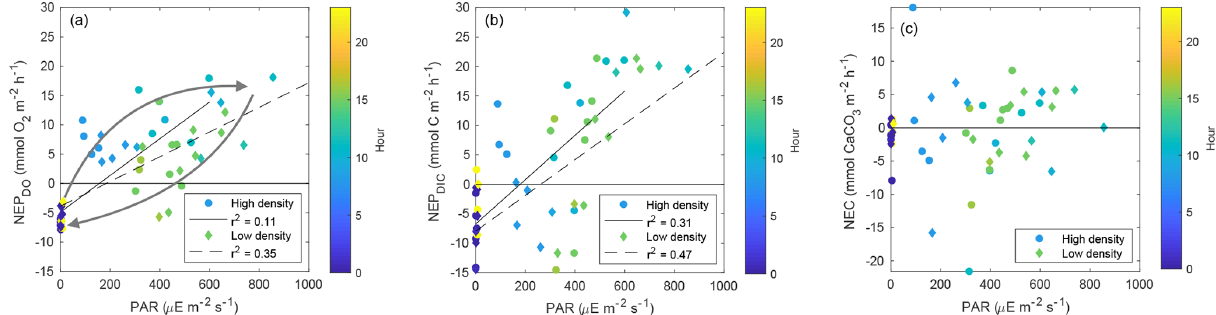
Figure 7. Scatter plots of (a) NEP DO vs. PAR, NEP DIC , and NEC vs. PAR (b–c) . Points are colored by the average hour for the respective time period over which NEP or NEC was calculated. The arrows in (a) are intended to highlight the hysteretic pattern between PAR and NEP DO .